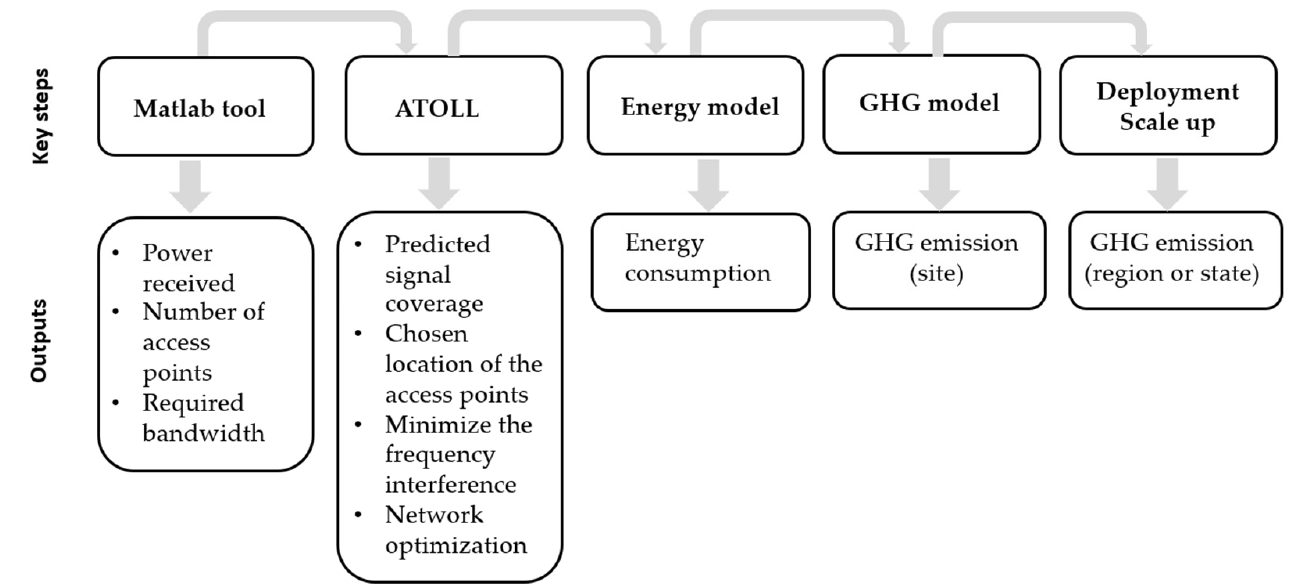
Figure 1. Schematic representation of the proposed framework.